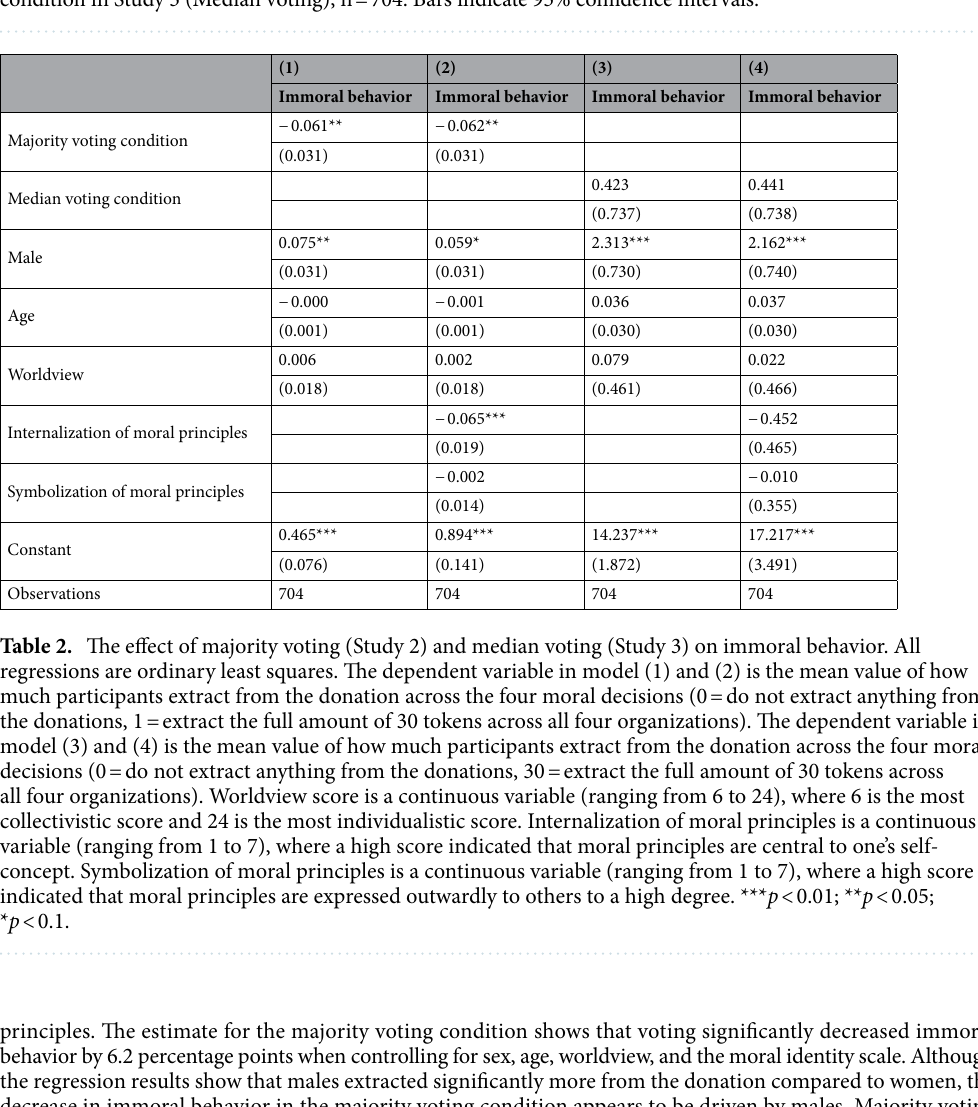
significantly decreased immoral behavior by 18 percentage points for males, while selfish behavior among females remained unaffected (see Table S6 in Supplementary Materials). The regression results also show that internaliza- tion of moral principles was associated with less immoral behavior, while symbolization of moral principles and worldview were not significantly correlated with immoral behavior.